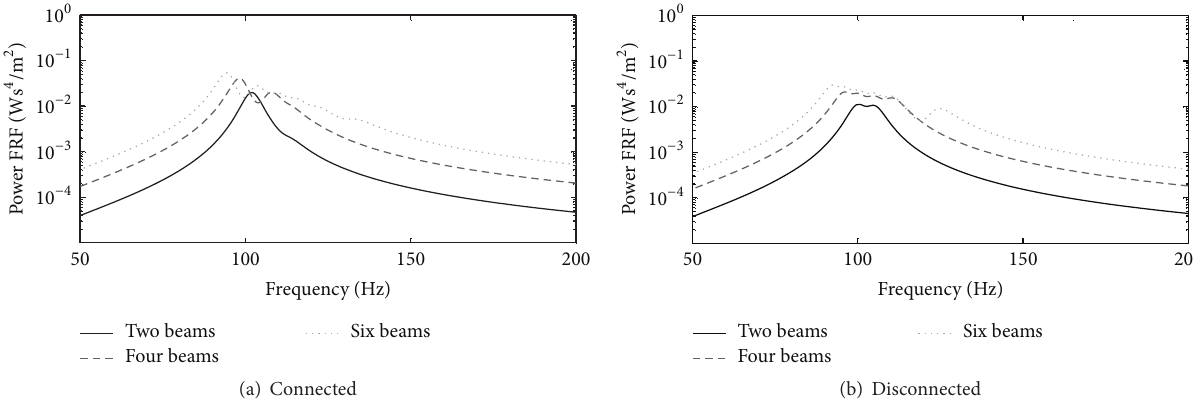
= 0.15𝑚𝐿 , 𝑀 = 0.20𝑚𝐿 , 𝑡,1 𝑡,2